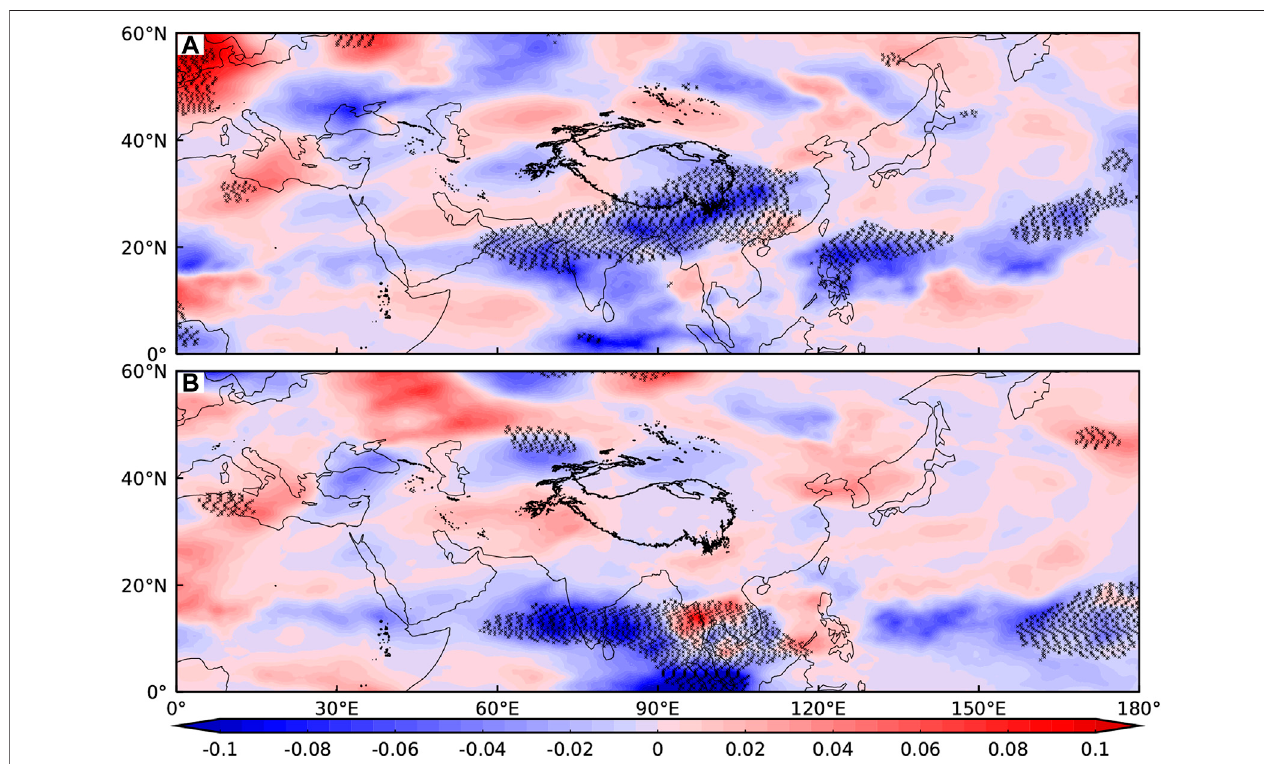
FIGURE 6 | Information fl ow between the Indonesia SST index (ISI) and TCO* (shading). Black dots represent signi fi cant information fl ows at the 90% con fi dence level; (A) T 1 → 2 : ISI → TCO p and (B) T 2 → 1 : TCO p → ISI .